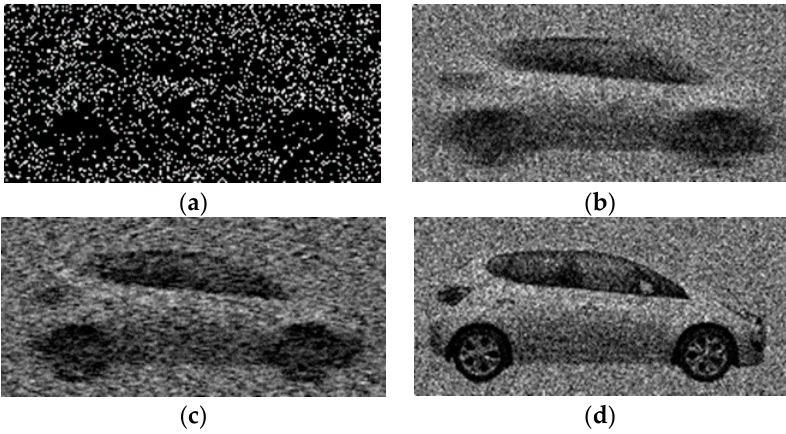
Figure 1. Synthetic Quanta Image Sensor (QIS) images of a car, with a maximum photon rate of 0.2 photons/pixels/bit-plane, typical of low light conditions: ( a ) Single bit-plane exposure (10 µs); ( b ) Sum of 50 bit-plane exposures of a car moving at 300 km/h; ( c ) Image b after motion deblurring using the Wiener Filter (deconvwnr function in Matlab, with the assumption of a noise-power-to-signal-power ratio of 0.05); ( d ) Sum of 50 bit-planes for static car.